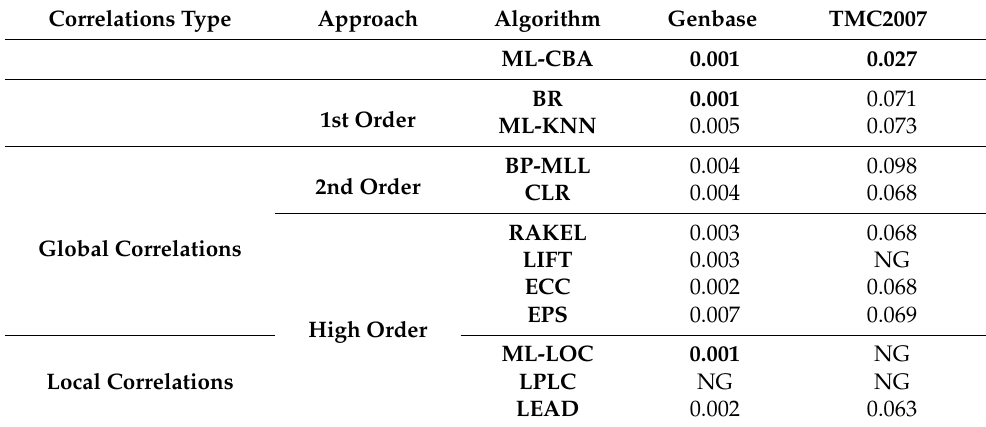
Table 7. The Hamming loss results of the proposed ML-CBA algorithm on the large-sized datasets, with respect to several other MLC